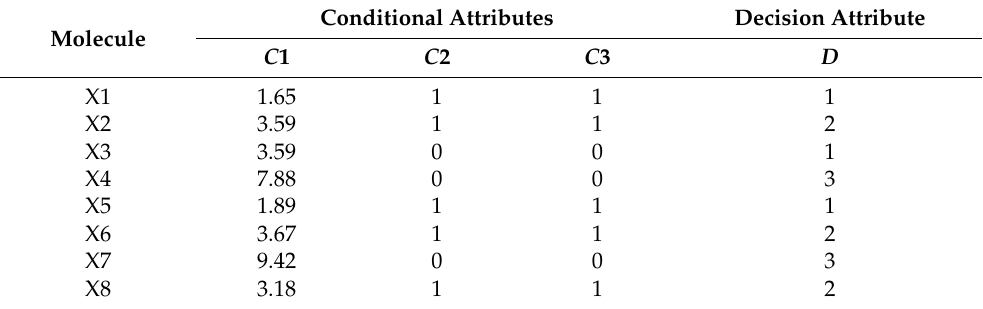
Table 5. Simplified information